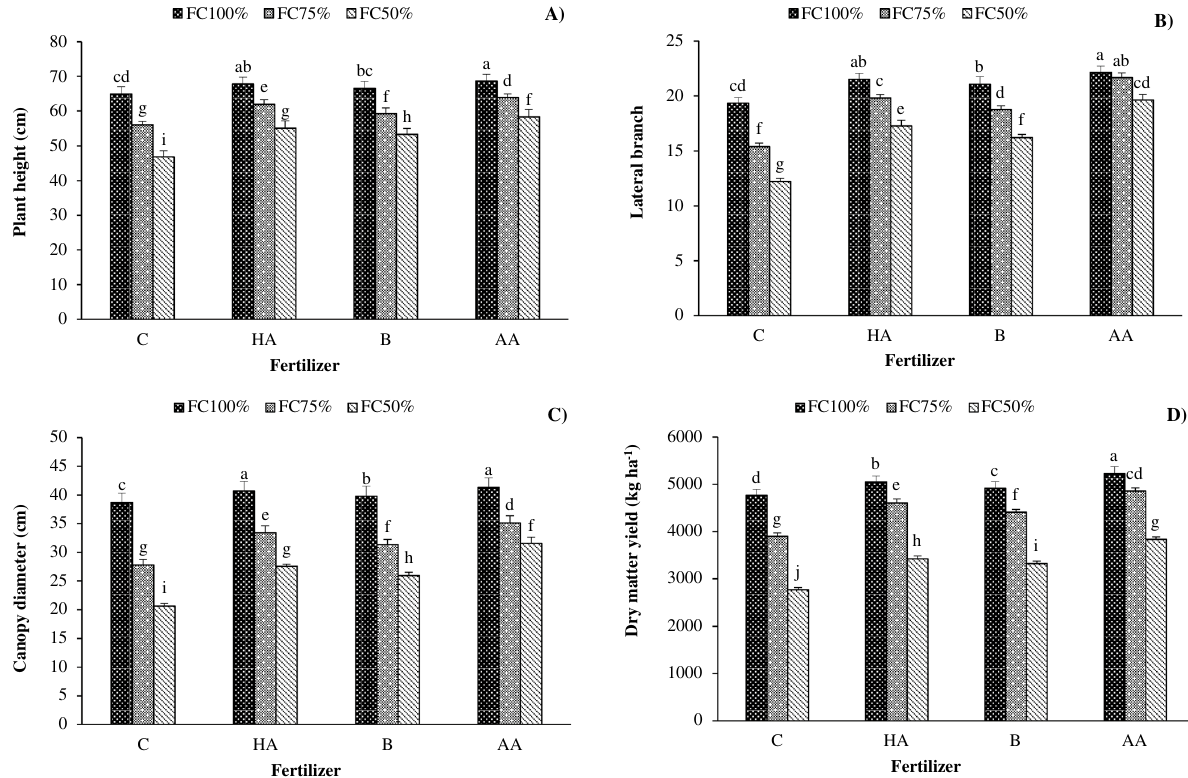
Figure 1. Interaction effects of irrigation regime and biofertilizer application on ( A ) plant height, ( B ) lateral branch, ( C ) canopy diameter, and ( D ) dry matter yield in savory. C control, HA humic acid, B bacterial, AA amino acid. Different lower-case letters above bars indicate significant differences at P <